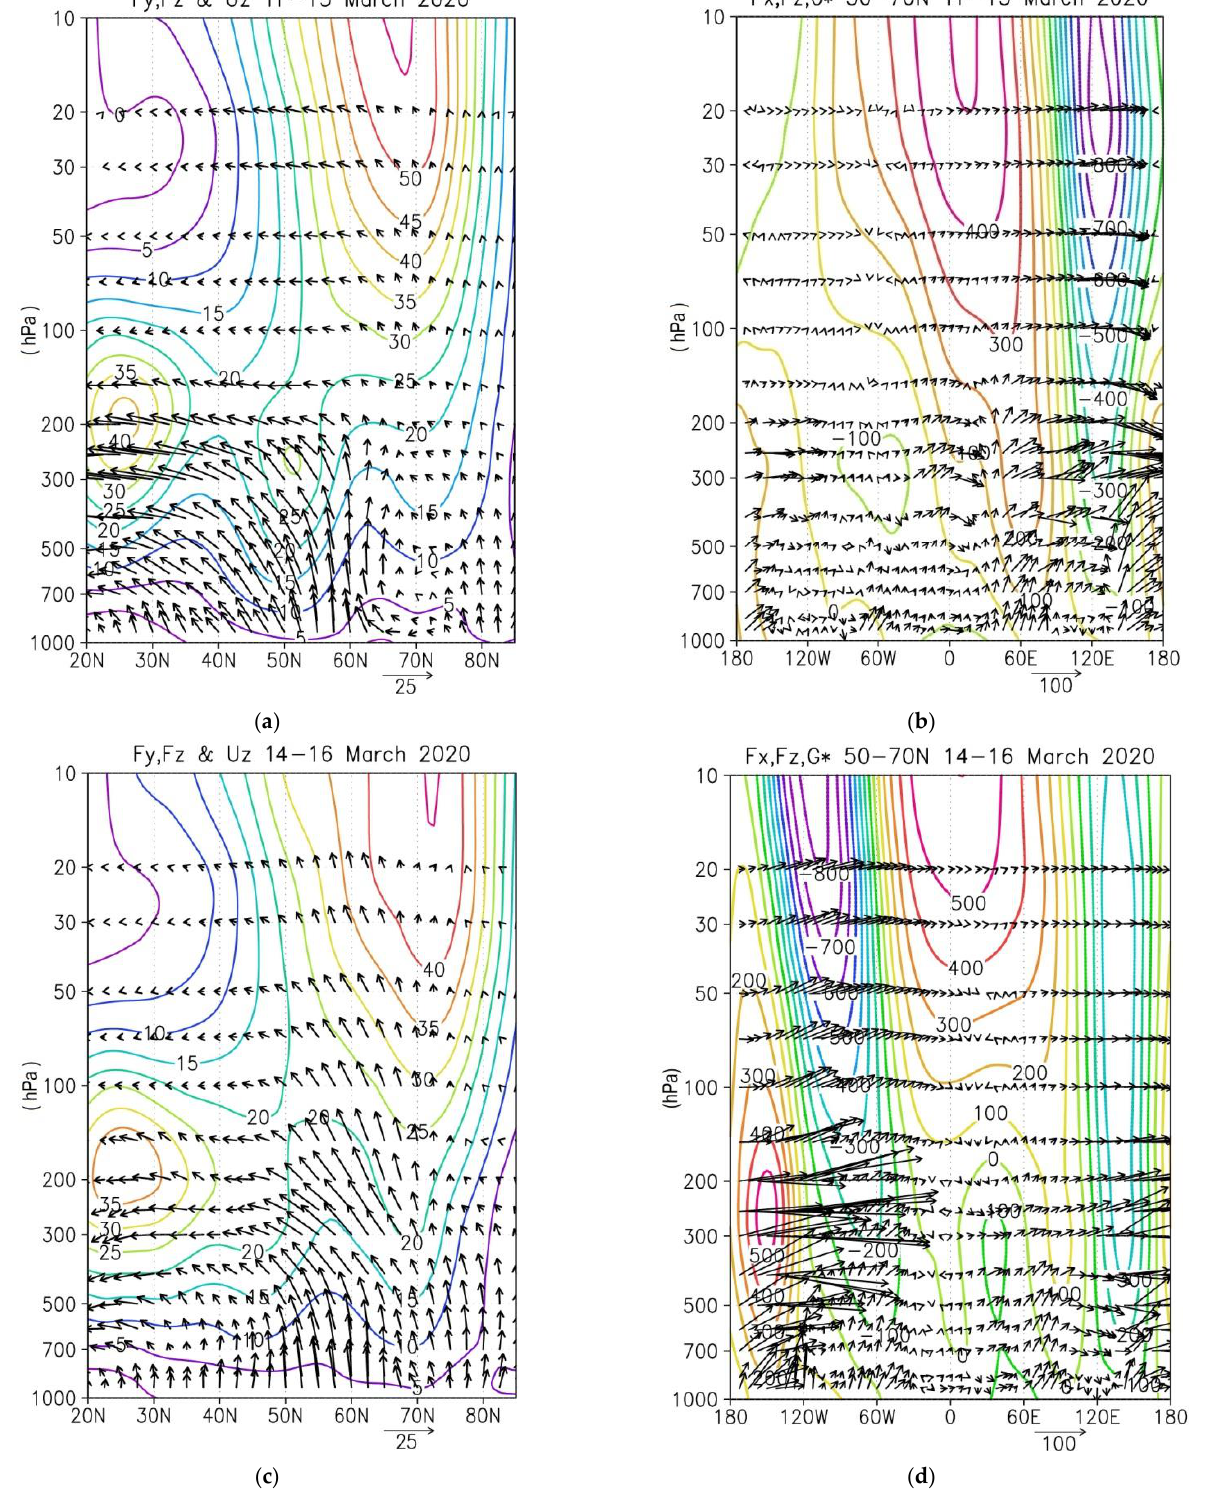
Figure 6. Altitude–latitude diagram of zonal mean Plumb fluxes (Fy, Fz components) and zonal mean zonal wind on 11–13 March ( a ) and 14–16 March 2020 ( c ). Altitude–longitude diagram of Plumb fluxes (Fx, Fz components) and geopotential height deviation from zonal mean G* (gpm) averaged over 50–70° N and the same periods ( b , d ). The vertical component of wave activity flux was multiplied by a factor of 100.